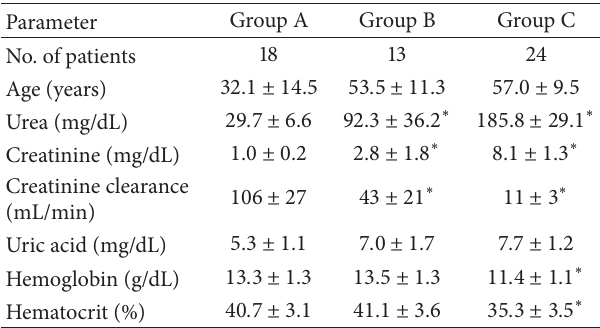
Table 1: Clinical data and laboratory results in 55 patients with